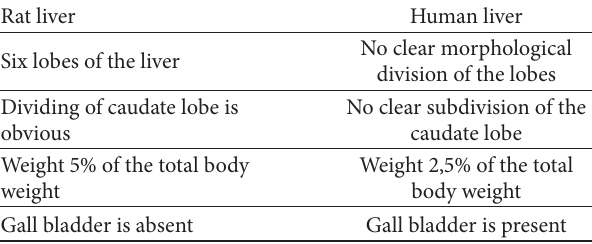
Table 2: Morphological comparison of the rat and human liver.